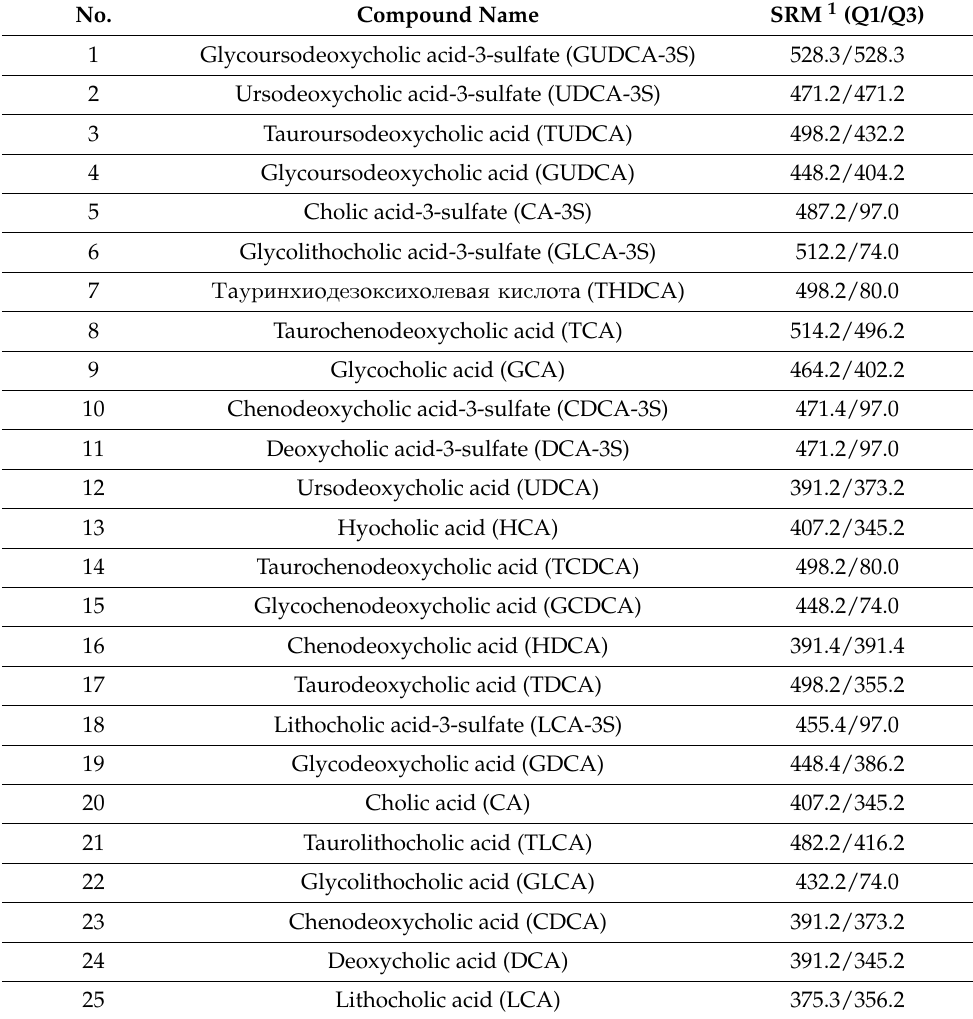
Table 2. Parameters of mass-spectrometric detection (MS/MS) of some bile